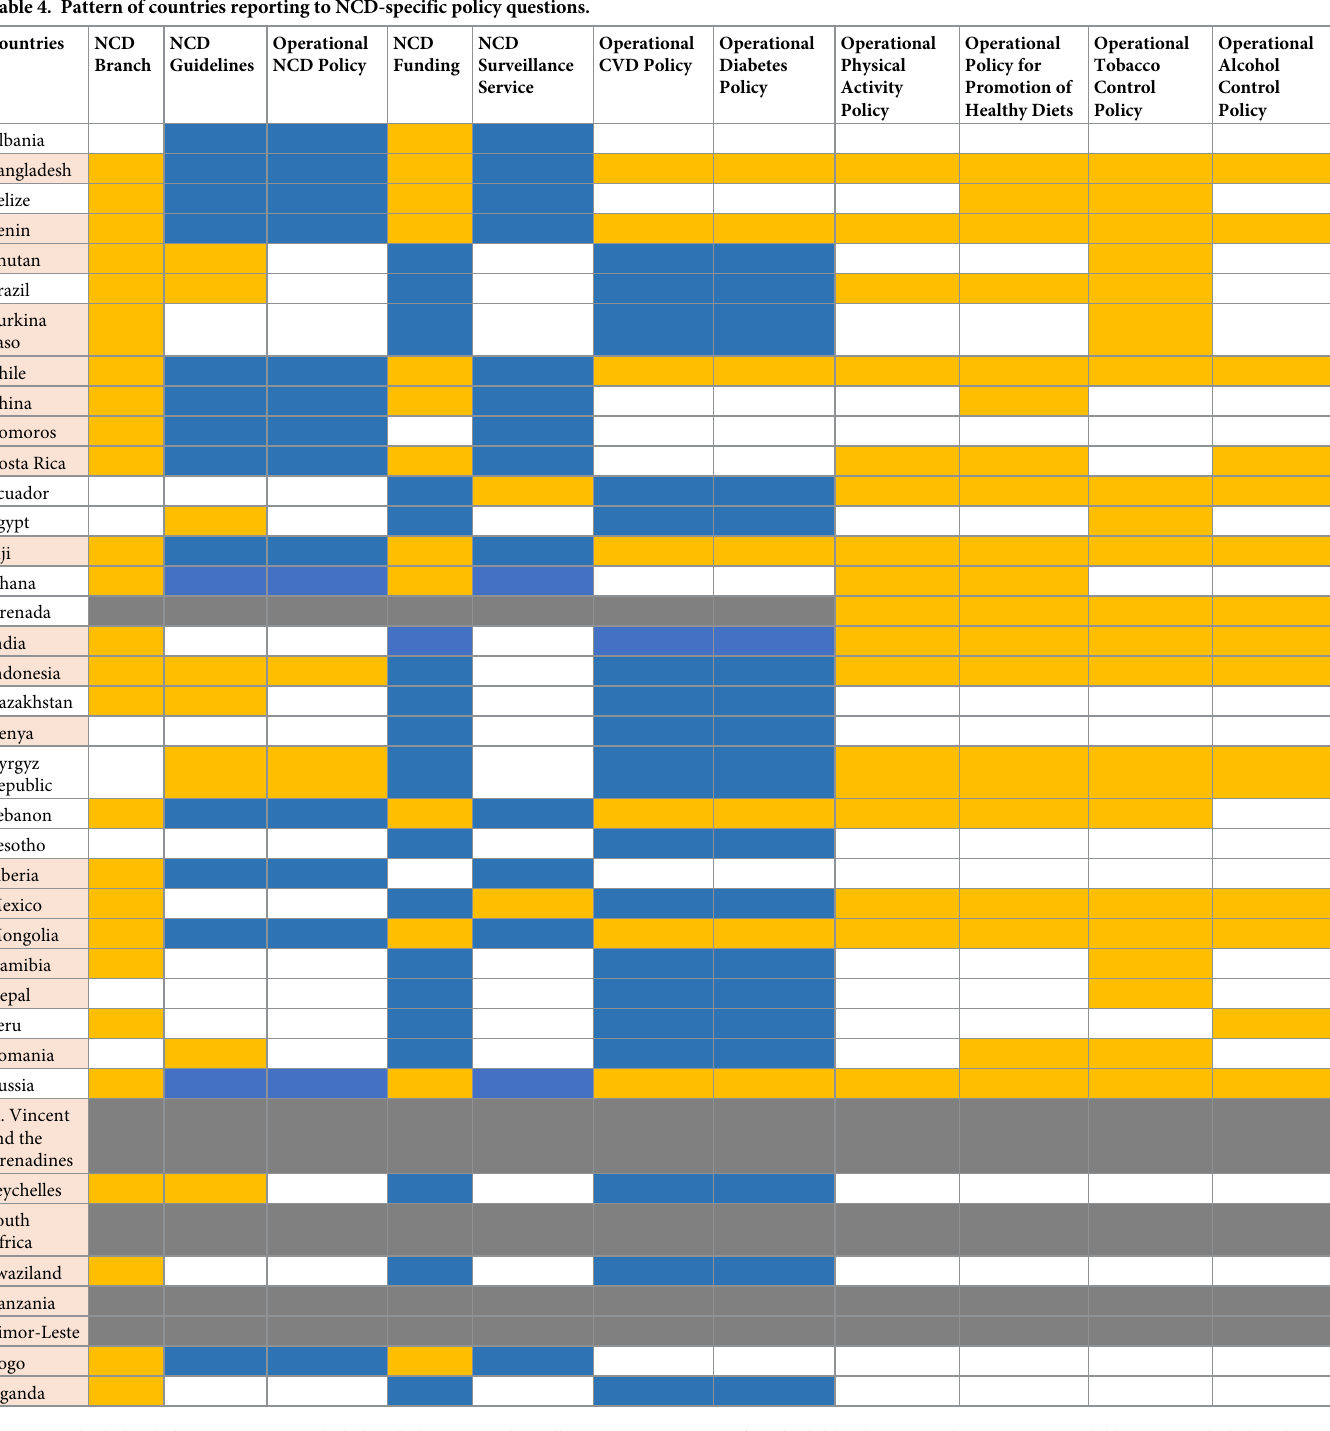
Table 4. Pattern of countries reporting to NCD-specific policy questions. Countries